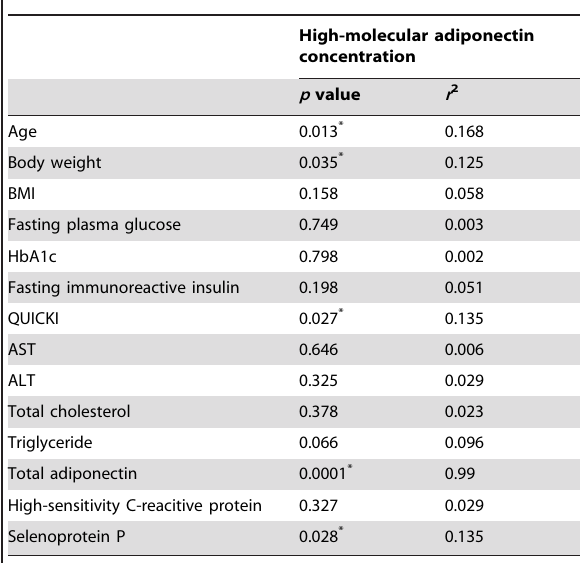
Table 3. Linear regression analysis of high-molecular adiponectin concentrations with clinical